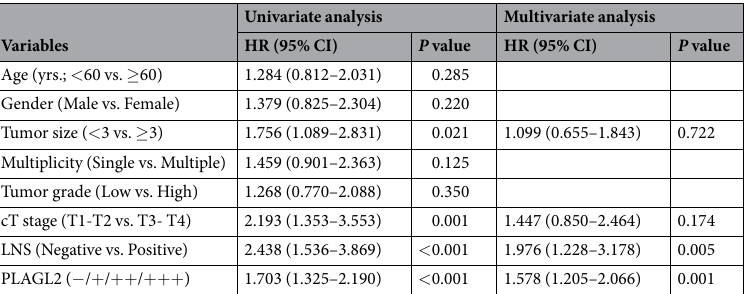
Table 6. Univariate and multivariate Cox proportional hazards analyses for the five-year